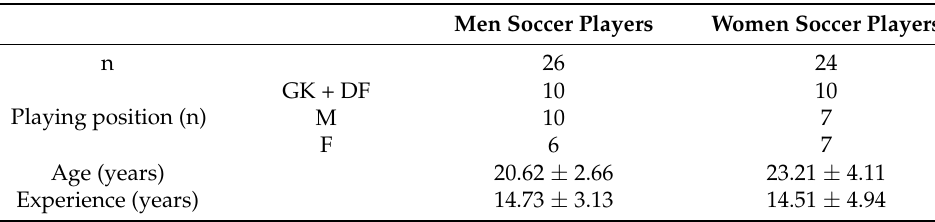
Table 1. Characteristics of the